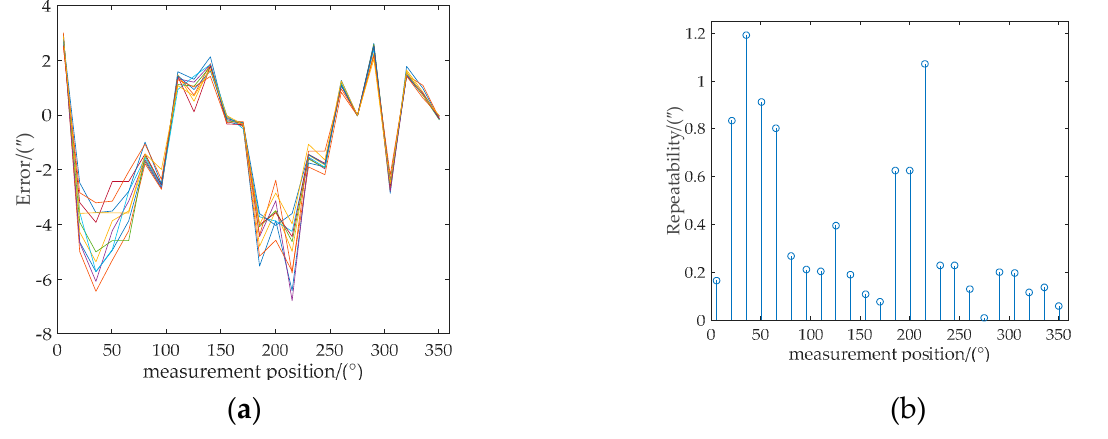
Figure 9. ( a ) The 10 testing datasets of compensation errors. ( b ) The repeatability at 24 angle measurement positions of compensation results. Table 4. Accuracy analysis.